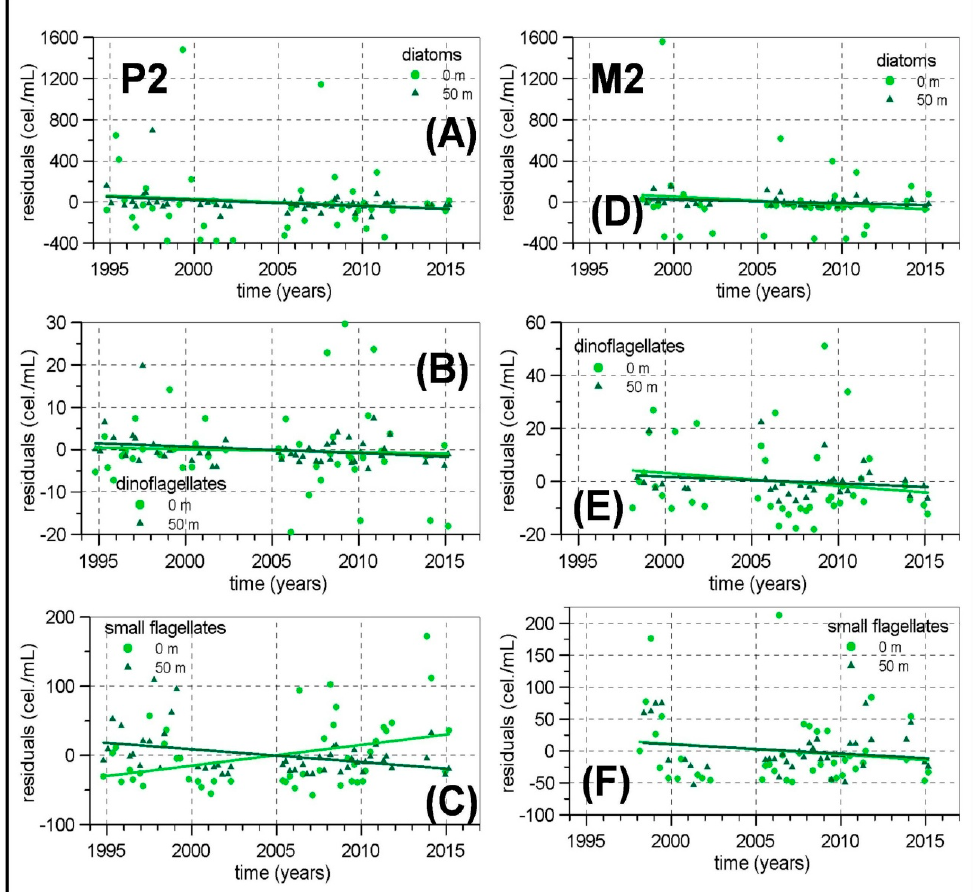
Figure 8. Time series of residuals of the micro-phytoplanktonic time series at stations P2 and M2. ( A – C ) correspond to diatoms, dinoflagellates and small flagellates at station P2. ( D – F ) correspond to diatoms, dinoflagellates and small flagellates at station M2. In all the figures light green dots are used for the time series of residuals at 0 m depth, and the dark green dots are used for the time series of residuals at 50 m depth. Solid lines are the straight lines fitted by means of least squares fit to each time series.